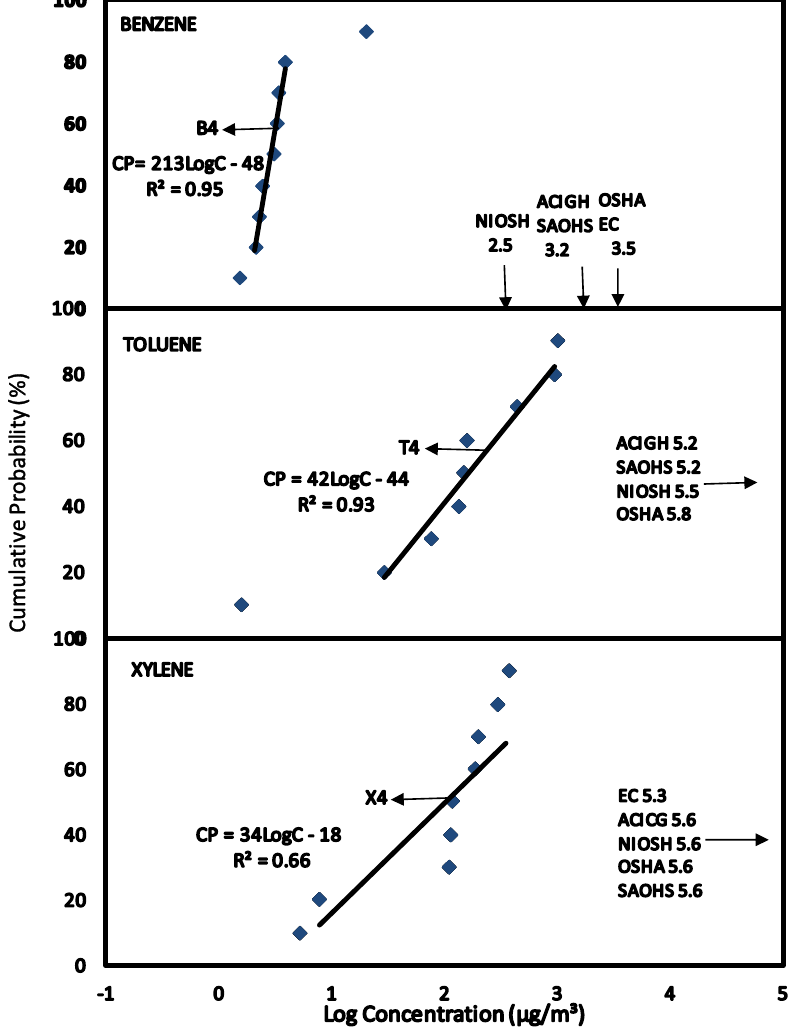
Figure 4. Scenario 4, CPD plots for exposure of workers to concentrations of benzene, toluene and xylene in the air of offices of service stations as measured by personal air sampling